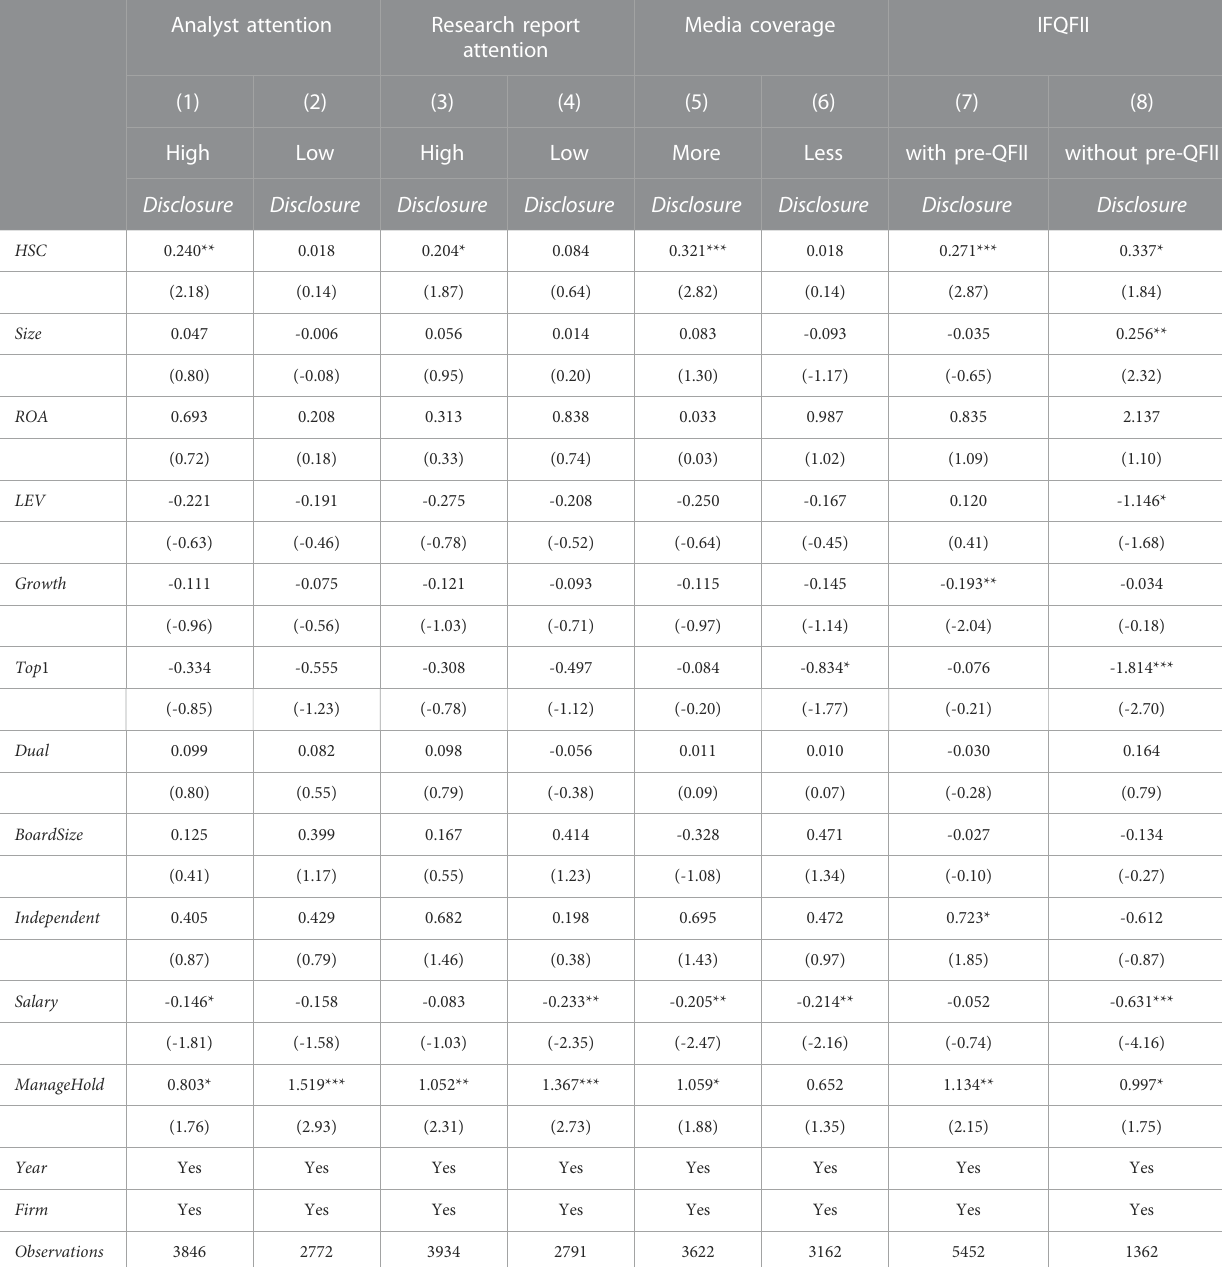
TABLE 5 Capital Market Liberalization and ESG Disclosure: by External Environment: This table shows how the effect of capital market liberalization varies by the external environment. The sample fi rms are divided into two groups each month based on the analyst attention, the research report attention, the media coverage, and the presence of QFII ( IFQFII ), respectively. Analyst attention is the number of analyst teams that have conducted analysis on the fi rm within a year. Research report attention is the number of research reports that have tracked and analyzed the fi rm within a year. Media coverage is the total number of news aboutthe fi rmappearinginnewspaper fi nancialnewscontentwithinayear. IFPQFII isanindicatorvariablethatequalsto1ifthe fi rmhasforeigninvestorsbefore the implementation of the mainland-HK Stock Connect (with pre-QFII), and 0 otherwise (without pre-QFII). The tests are ordered logistic regressions where the dependent variable is the fi rm-level ESG disclosure score ( Disclosure ). The explanatory variables are the dummy variable that represents the mainland-HK Stock Connect ( HSC ) and several control variables including Size , ROA , LEV , Growth , Top 1, Dual , BoardSize , Independent , Salary , and ManageHold . Refer to Table 1